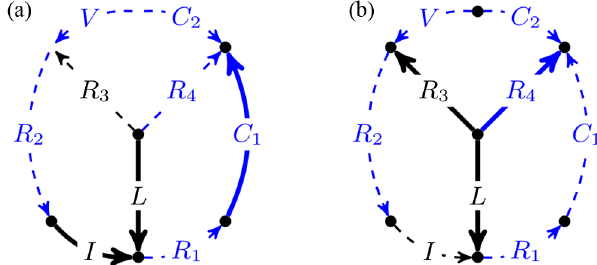
FIG. 9. Cut sets corresponding to twig C 1 (a) and to twig R 4 (b). The edges corresponding to a cut set are indicated with thick lines, while the others are shown with dashed